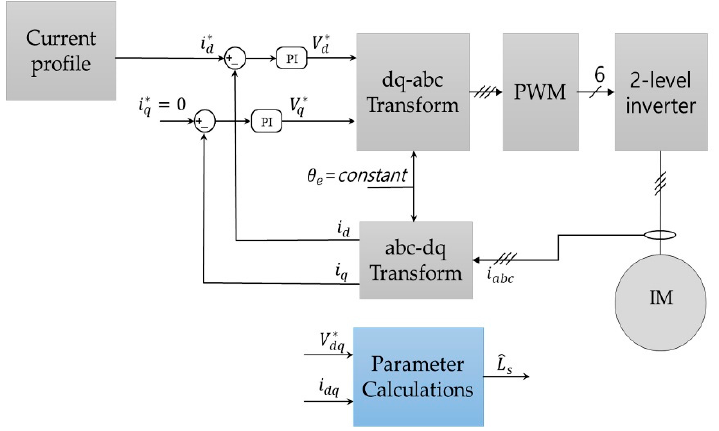
Figure 1. Block diagram of a conventional standstill test used for stator inductance identification.